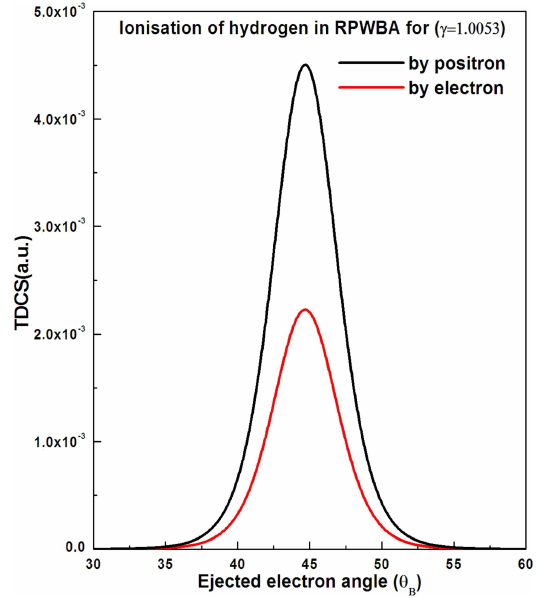
Figure 5. The incident kinetic energy is T i = 2700 eV, the ejected electron kinetic energy is